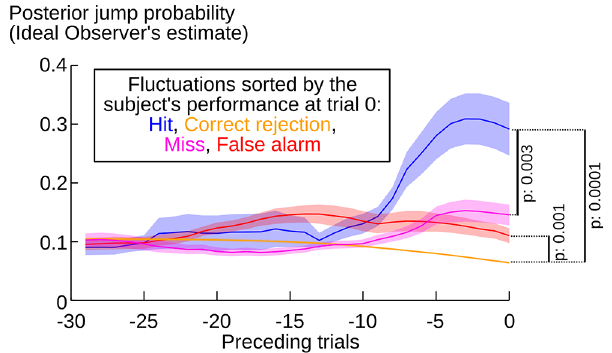
Fig 3. Accuracy of the subjects' jump detections. Subjects ’ jump detections followed the fluctuations in jump likelihood provided by the sequence of stimuli. Each trial was sorted into four categories (hit, miss, correct rejection and false alarm), based on the comparison between the subjective jump detection and the actual position of jumps in the sequence. This sorting was used as a reference (trial 0) to examine the fluctuations in the posterior jump probability estimated by the Ideal Observer over the preceding trials. P- values correspond to two-tailed paired t-tests at trial 0. Solid lines and error shadings correspond to mean ± sem over